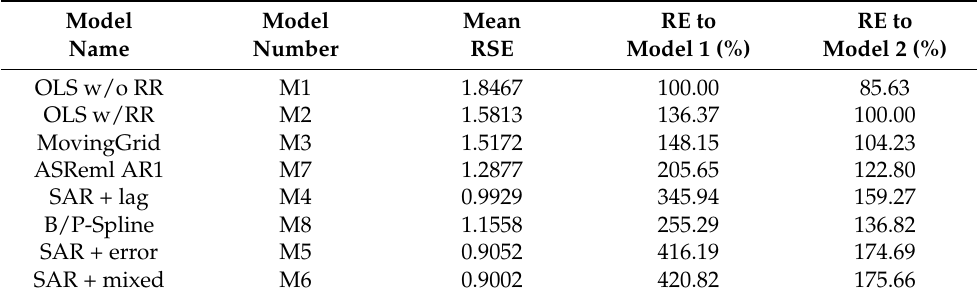
Table 11. Summary of relative efficiency (RE) and relative standard error (RSE) of spatial analysis of all models compared to model 1 (ordinary least square (OLS) without range and row) and model 2 (ordinary least square (OLS) with range and